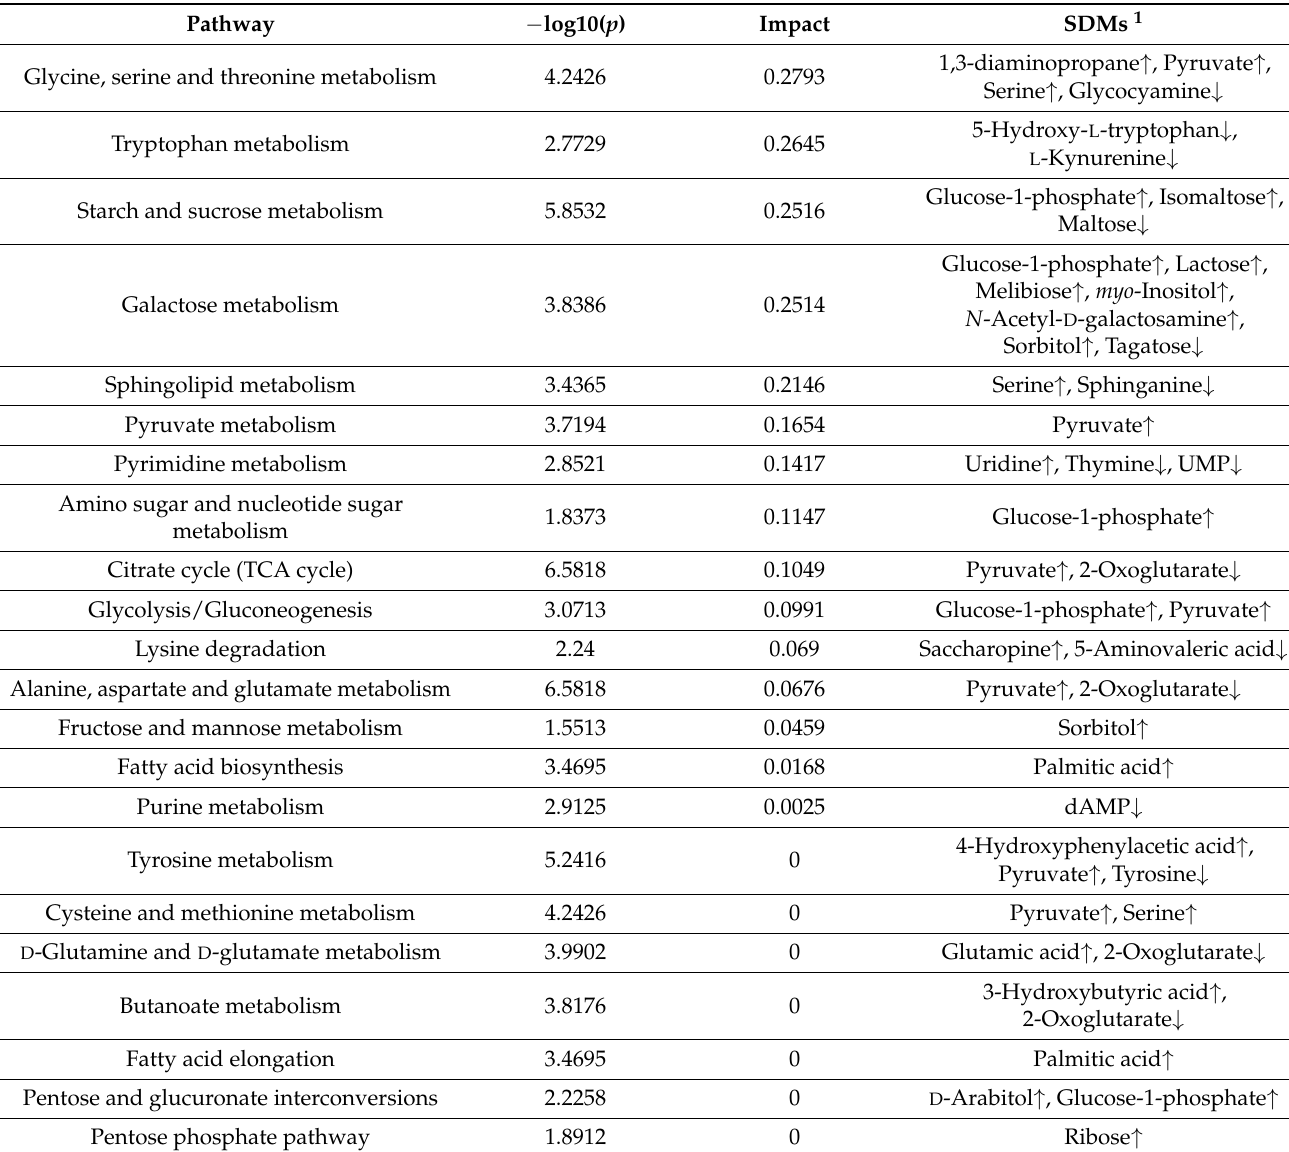
Table 3. Metabolic pathways identified from the significantly differentially abundant metabolites (SDMs) between termites fed M. micrantha leaves (ML) and pinewood (PW)